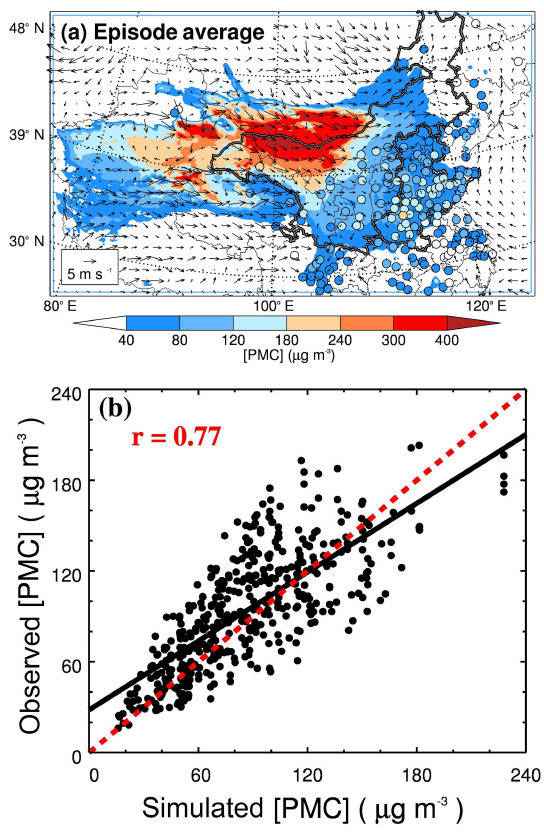
Figure 4. (a) The distribution of calculated (color contour) and ob- served (colored circles) episode-averaged [PMC], along with the simulated wind fields (black arrows). (b) Statistical comparison of simulated and observed episode-averaged [PMC], with the regres- sion line (black solid) and correlation coefficient ( r ). The red dashed line indicates the 1:1 line.